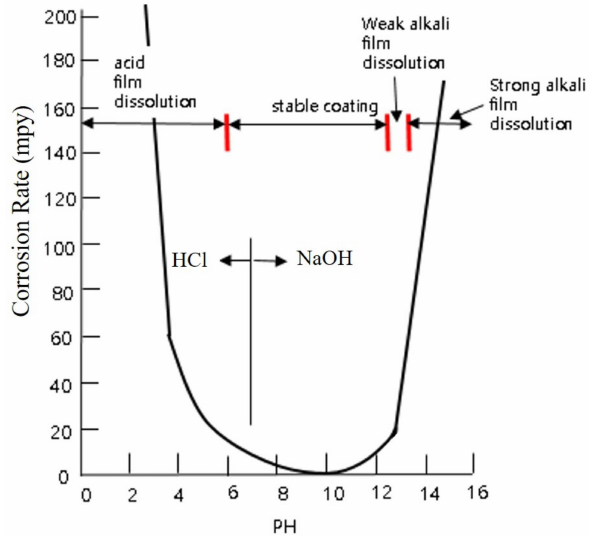
Figure 4. Zinc corrosion rate dependence on